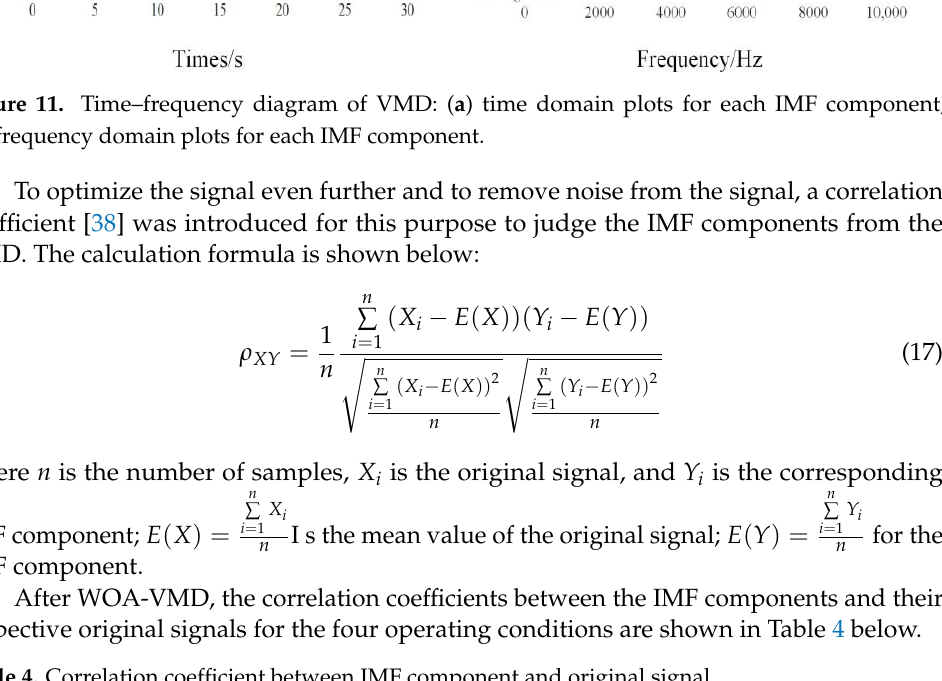
Table 4. Correlation coefficient between IMF component and original